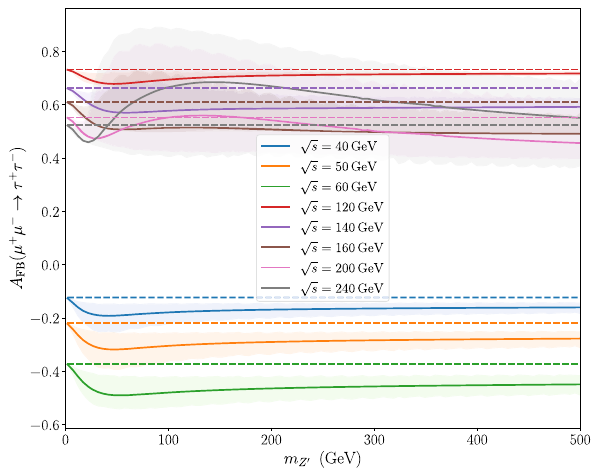
Fig. 14 A FB (μ + μ − → τ + τ − ) as a function of m Z (cid:2) for different val- √ s . Line code as in Fig. 12 ues of